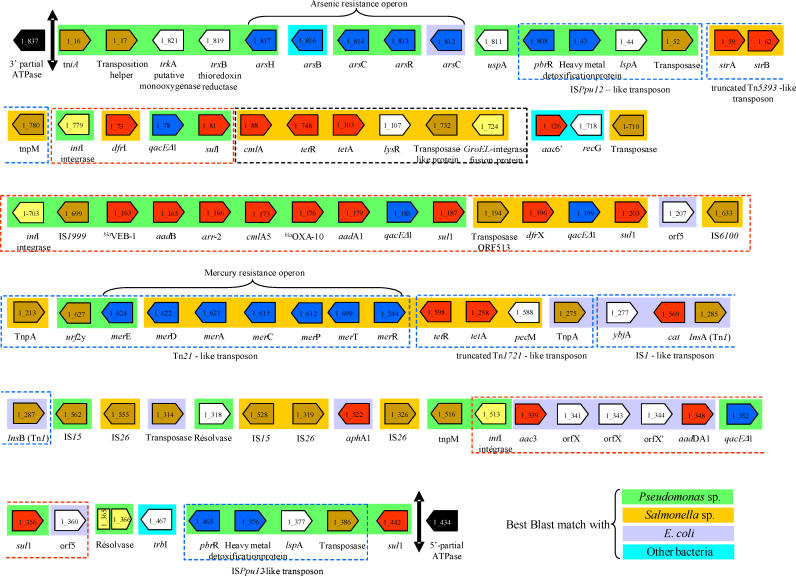
Layout of the Complete AbaR1 Inserted into the AYE Strain ATPase-Encoding GeneThe nomenclature of each ORF is indicated. Each ORF is identified according to EMBL entry CT025832. Colors are used to indicate ORF categories: resistance to antibiotics in red, resistance to heavy metals or antiseptics in blue, transposases in brown, integrases in yellow, and other functions in white. Genes exhibiting a best matching homolog in Pseudomonas are underlined in green, in yellow for Salmonella, in light blue for E. coli, and in turquoise for other bacteria. Complete integrons are indicated by red dashed lines. Transposons are indicated by blue dashed lines. Black dashed lines indicate a gene cluster found in Salmonella genomic island 1.